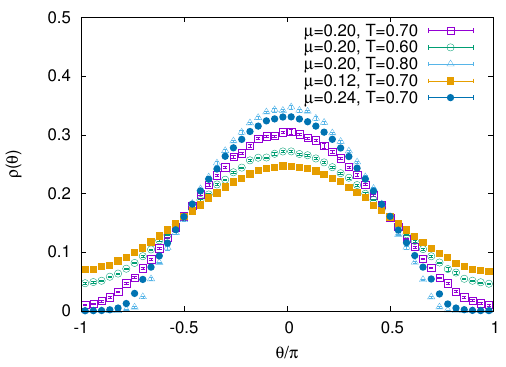
Figure 5 . The eigenvalue distribution (cid:26) ( (cid:18) ) for D = 3 ; N = 48 around the critical point ( (cid:22) c ; T c ) ’ (0 : 2 ; 0 :